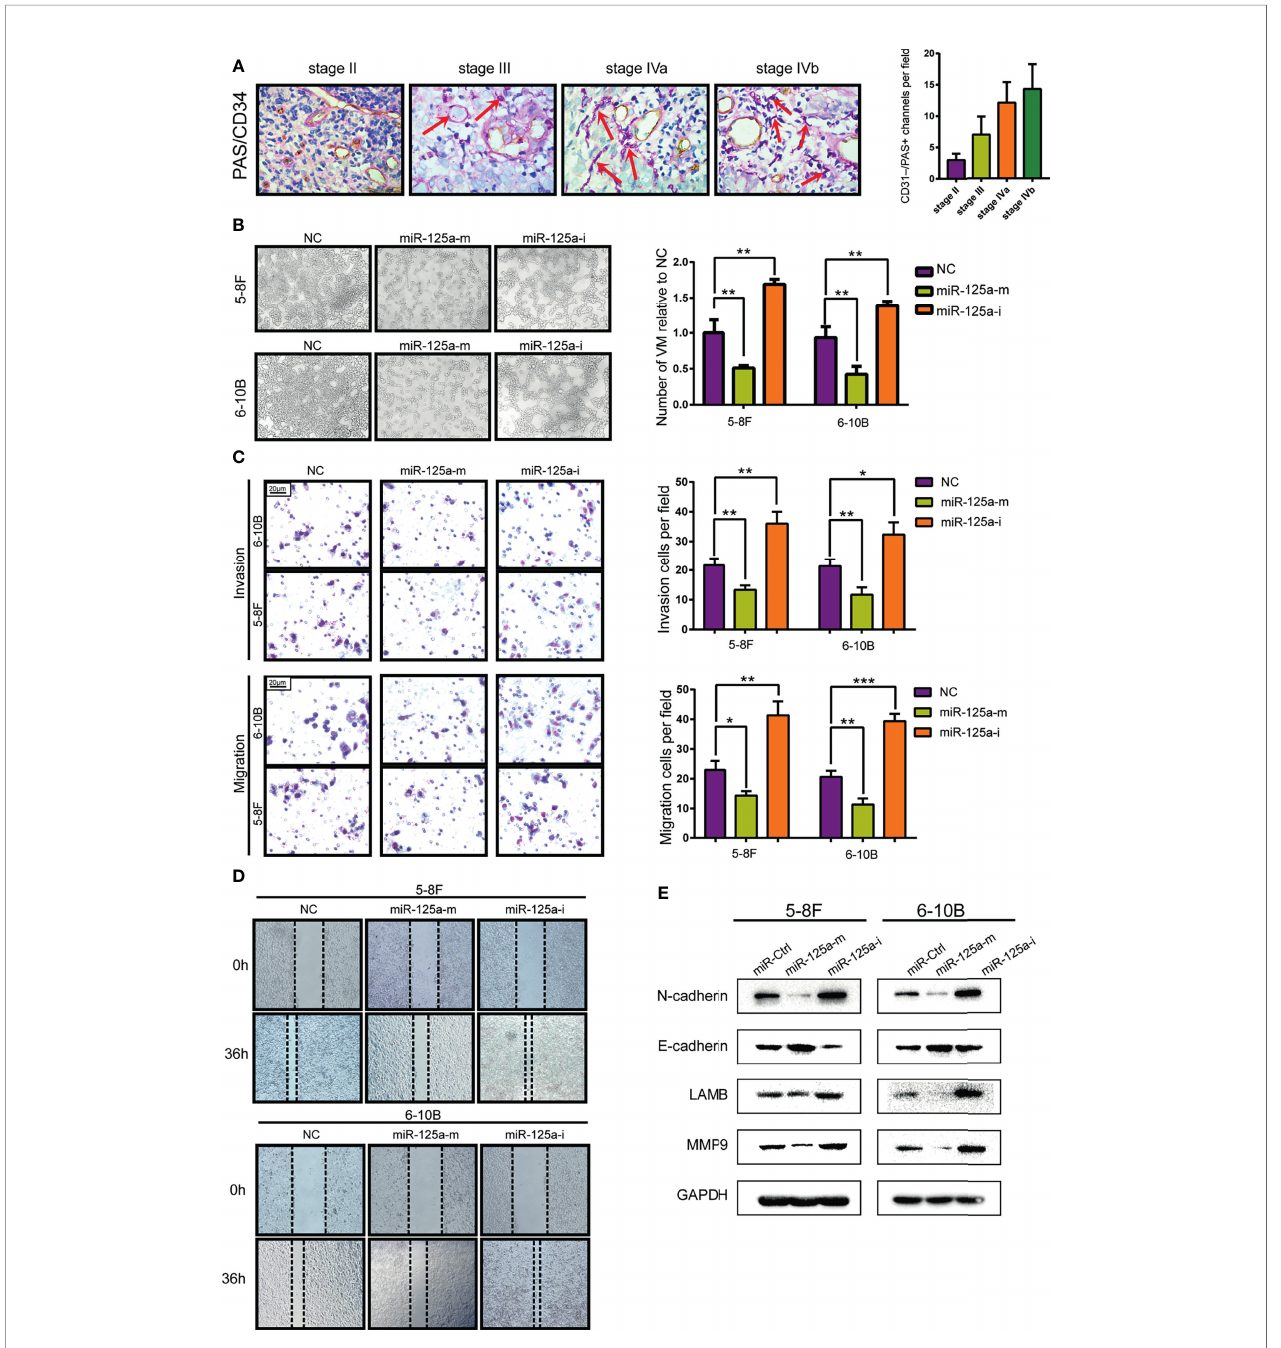
FIGURE 2 | MiR-125a decreases the level of VM formation, migration and EMT level of NPC cells. (A) NPC tissue at different stage (AJCC TNM Staging System 2017) staining by PAS/CD34 and corresponding histogram. (B) VM formation assay (left panel) and bar graph showing relative number of VM (right panel). (C) Invasion and migration transwell assay and histogram showing cell counting per fi eld. (D) Wound healing assay. (E) Western blot assay detecting EMT-related protein. (*P < 0.05; **P < 0.01; ***P <